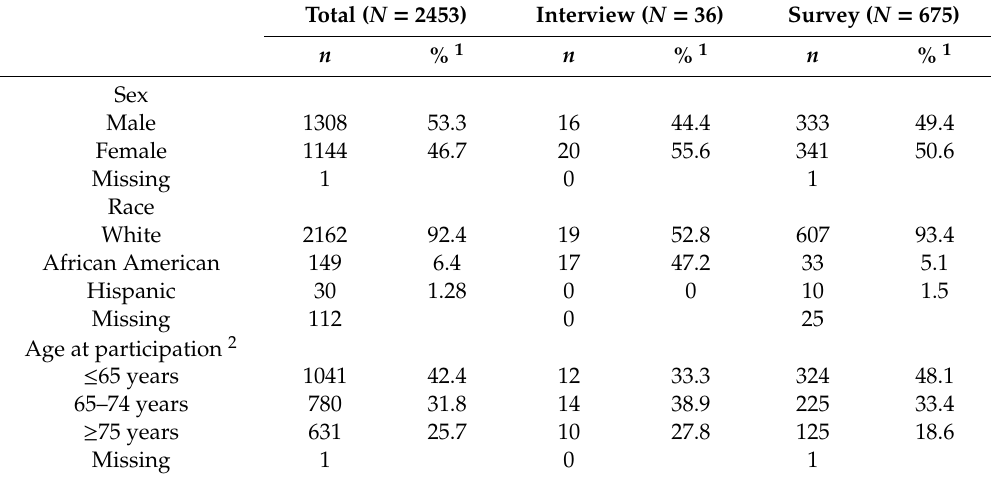
Table 1. Demographic characteristics for interview and survey among Electronic Medical Records and Genomics (eMERGE)